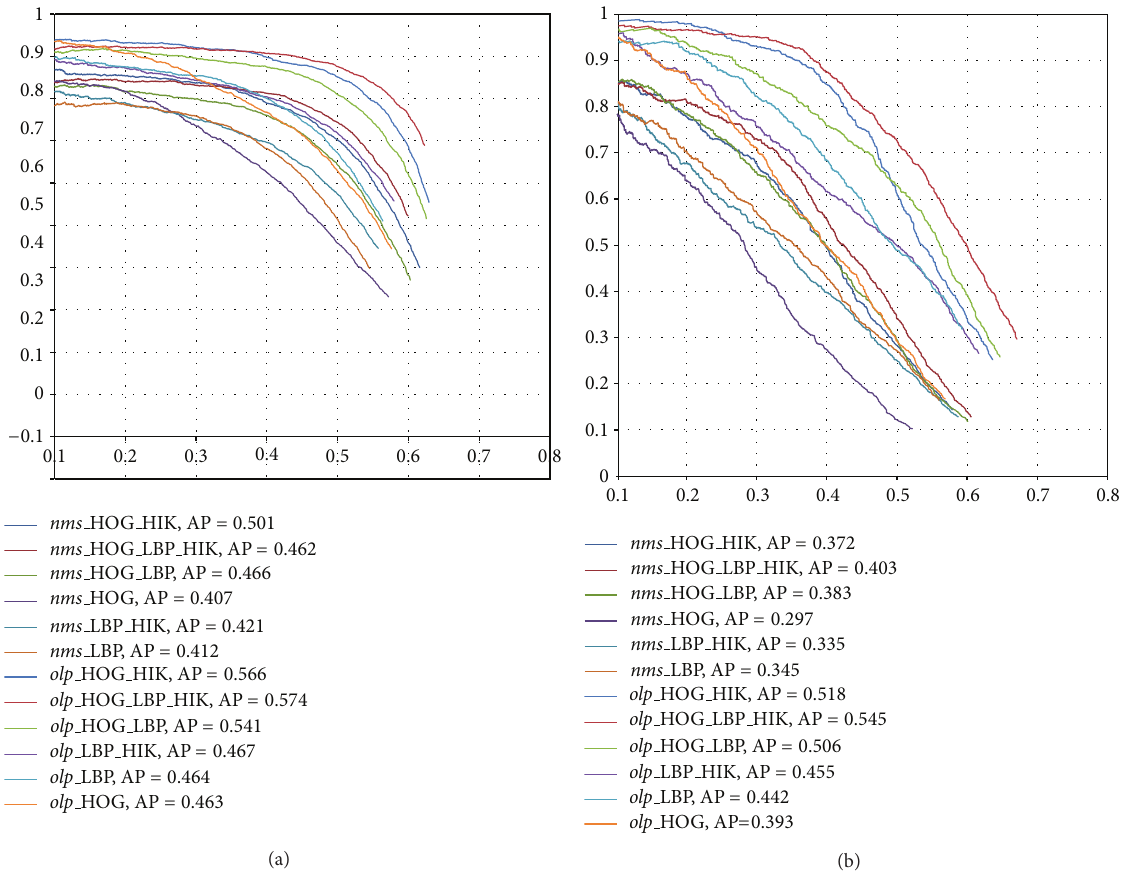
Figure 8: Comparison of precision and recalls achieved by using single features (HOG and LBP) and fusing HOG and LBP through various postprocessing: (a) XMU-VIS; (b) XMU